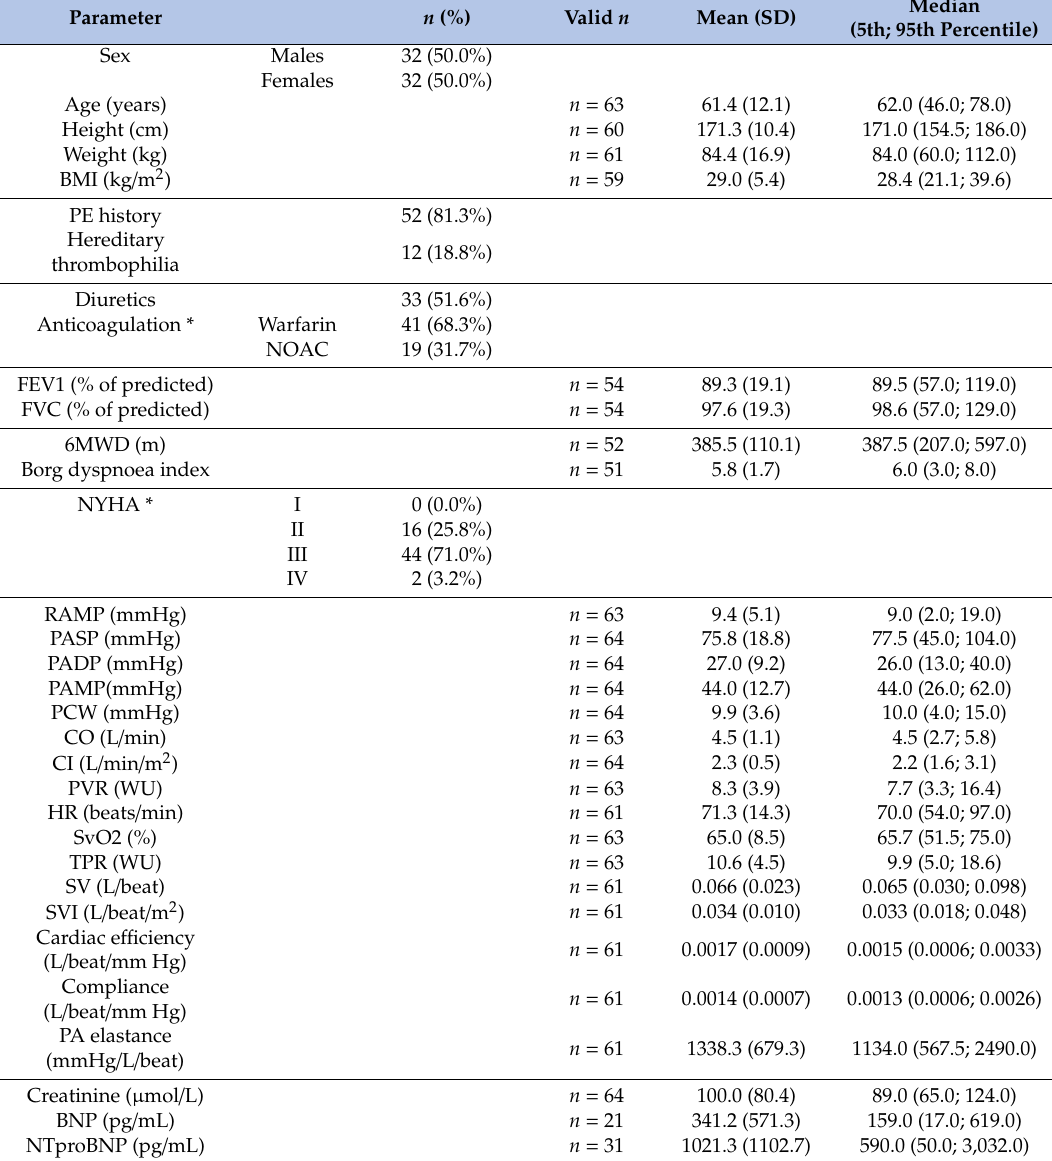
Table 1. Patient characteristics at the time of chronic thromboembolic pulmonary hypertension (CTEPH) diagnosis ( n =